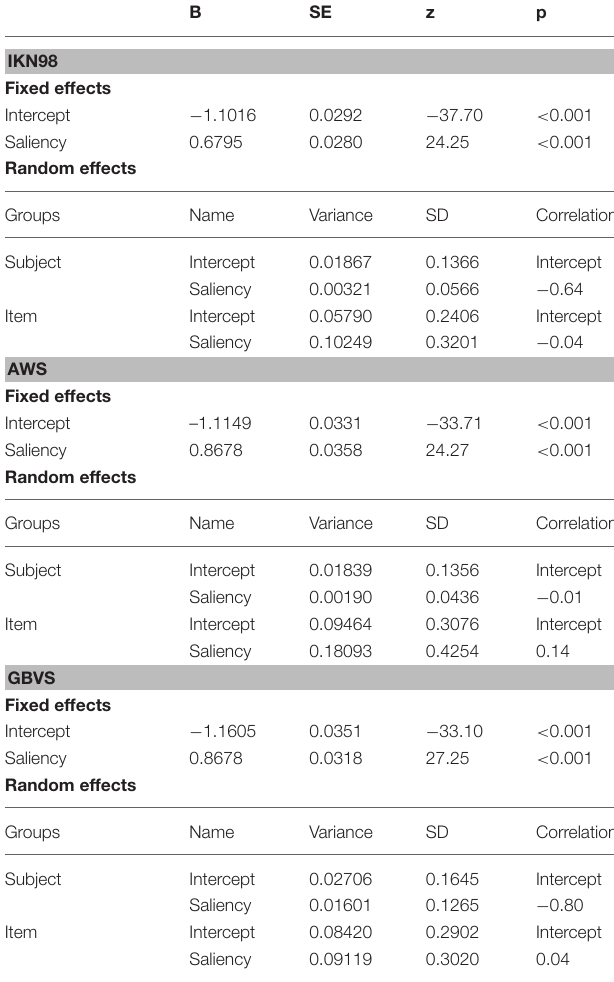
TABLE 2 | Three saliency-only GLMMs fitting fixation probability for a scene memorization